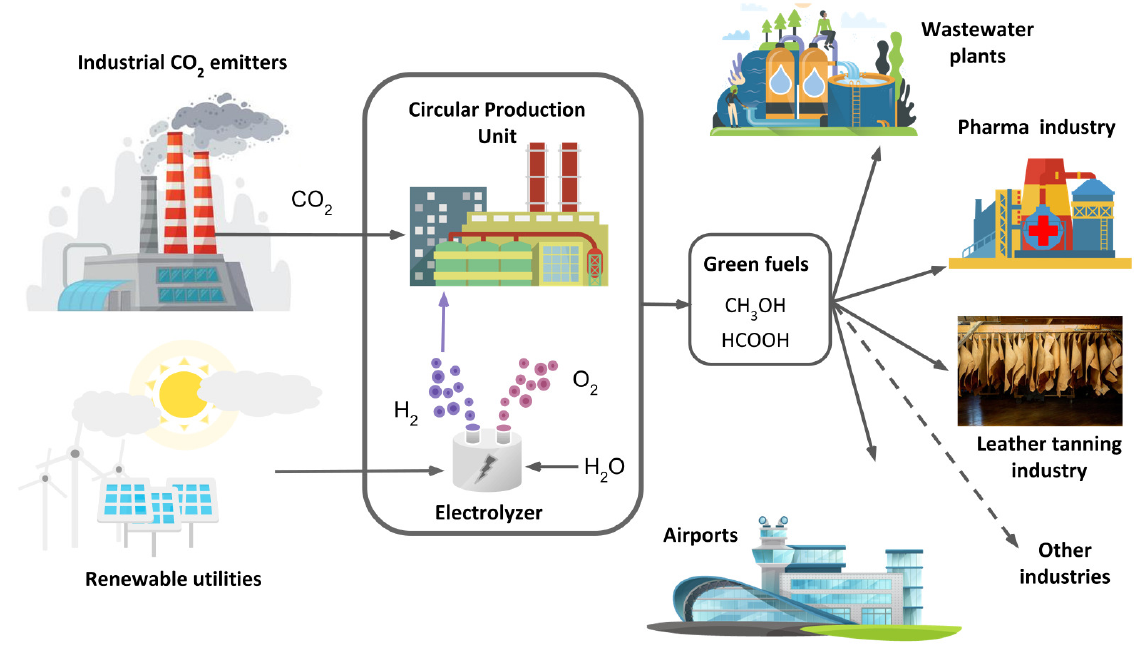
Fig. 1. Green fuel production ecosystem using industrial carbon emissions and renewable energy Apart from these green fuels, we are also investigating pathways to produce green ammonia, which acts as an efficient medium to store renewable energy (Patil & Sankaran, 2020a). We are presently studying the techno-economic and environmental feasibility of ammonia as a future energy source to fuel our industrial and transportation